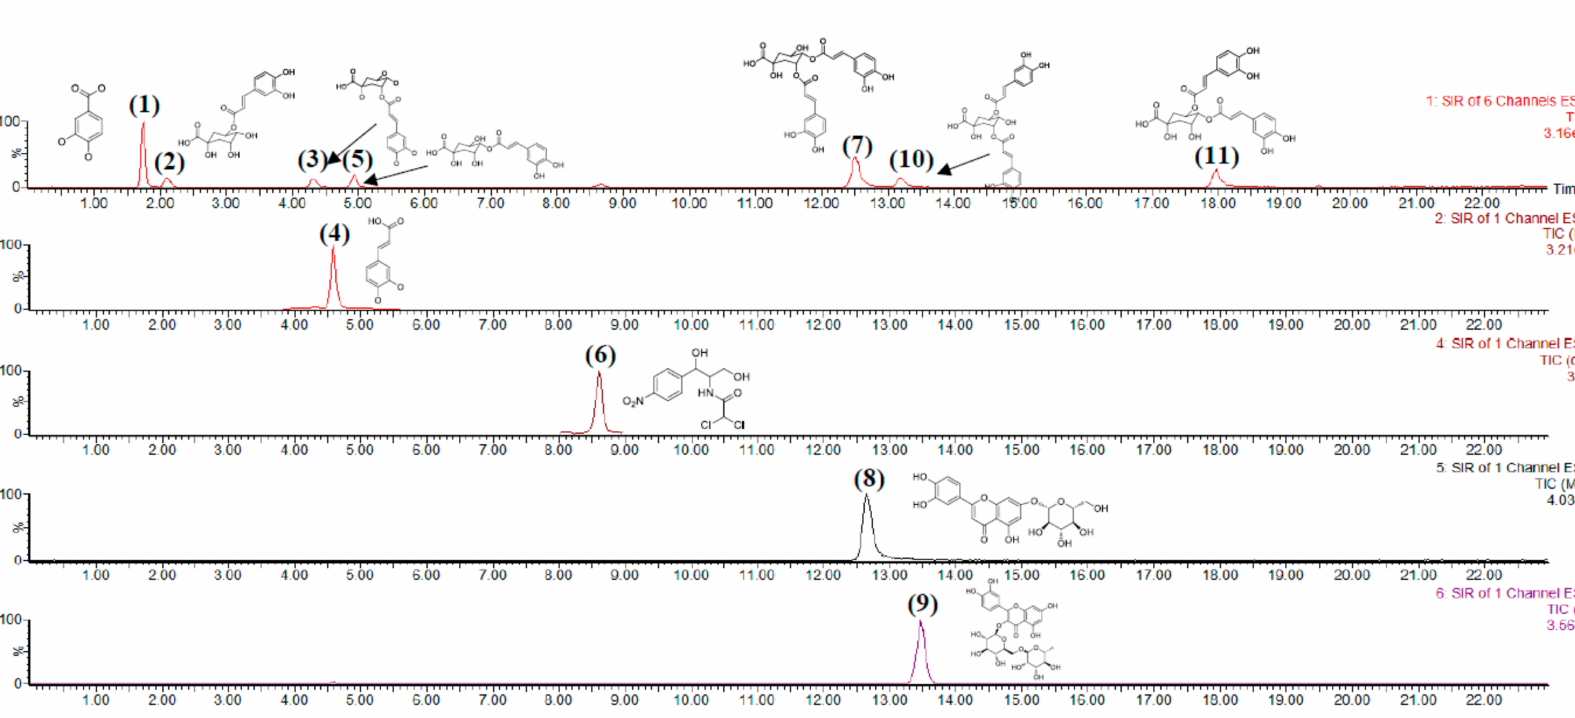
Figure 4. Extraction ion chromatograms of samples with IS of ( 1 ) 3,4-dihydroxybenzoic acid, ( 2 ) 5- O -ca ff eoylquinic acid, ( 3 ) 3- O -ca ff eoylquinic acid, ( 4 ) ca ff eic acid, ( 5 ) 4- O -ca ff eoylquinic acid, ( 6 ) IS (chloramphenicol), ( 7 ) 3,5- O -di-ca ff eoylquinic acid, ( 8 ) luteoloside, ( 9 ) rutin, ( 10 ) 3,4- O -di-ca ff eoylquinic acid, and ( 11 ) 4,5- O -di-ca ff eoylquinic